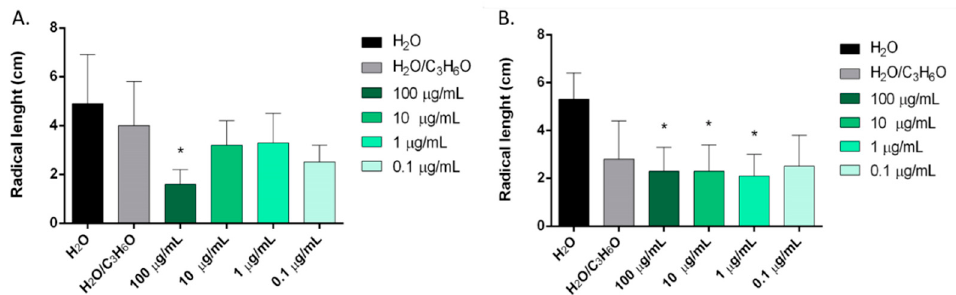
Figure 5. Phytotoxic activity of P. vera ( A ) and C. sativa ( B ) EOs against radical elongation of Raphanus sativus L., 120 h after sowing. Results are the mean ± standard deviation ( n = 3) of three independent experiments. * p < 0.05, compared to control (ANOVA followed by Dunnett’s multiple comparison test).